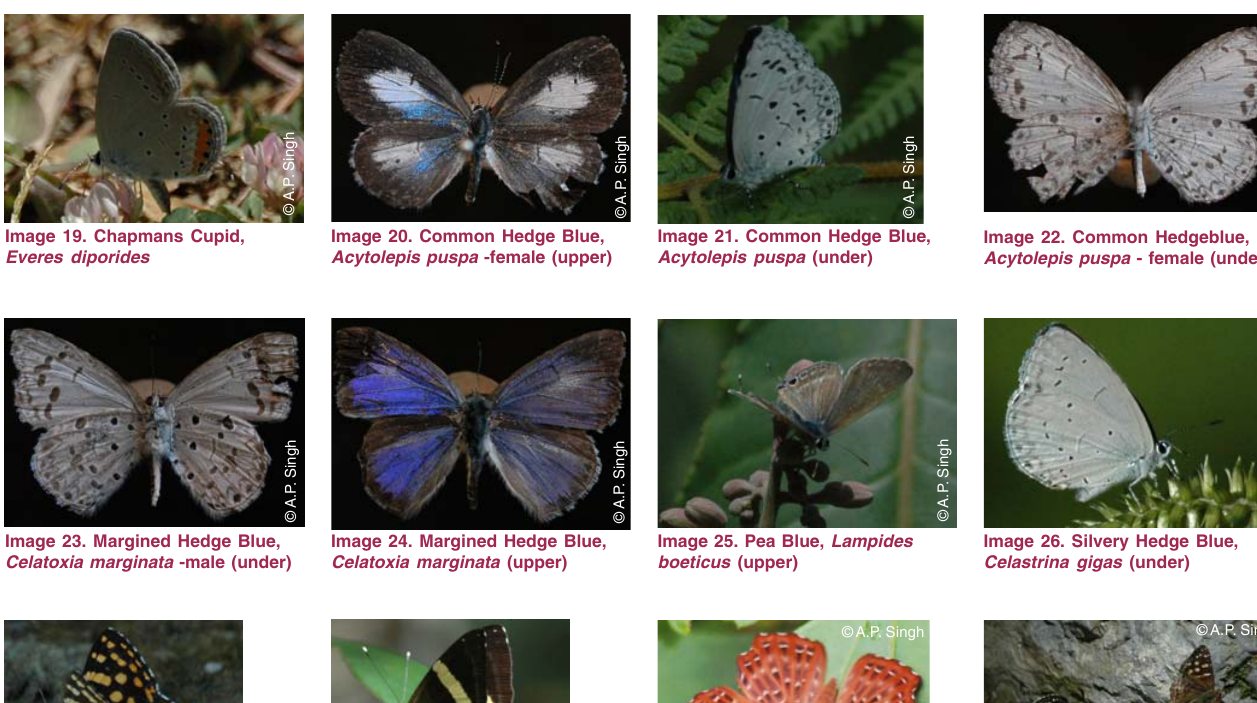
Image 29. Punchinello, Zemeros flegyas (upper)